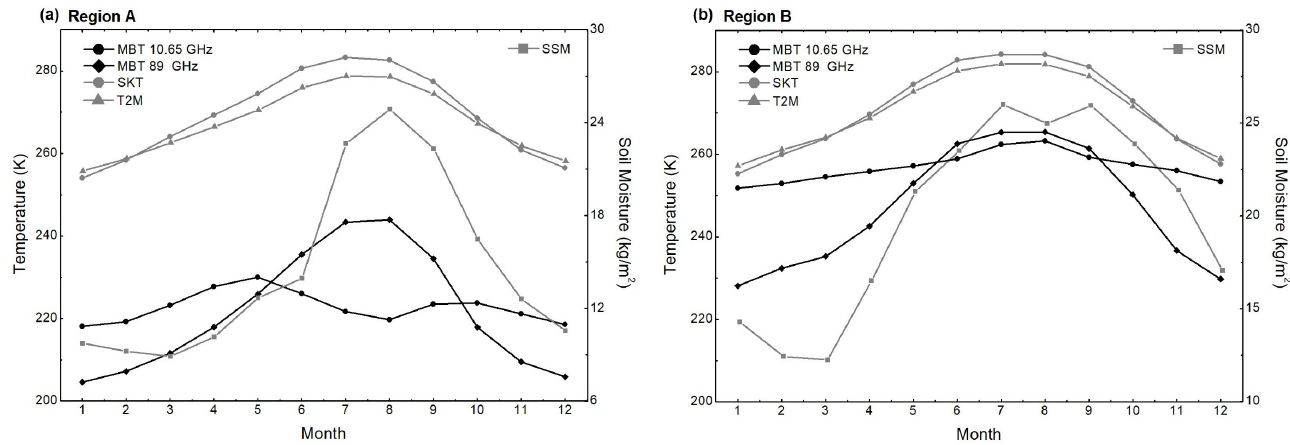
Figure 5. Variations of dual-frequency MBT, SKT, T2M and SSM in region A ( a ) and region B ( b